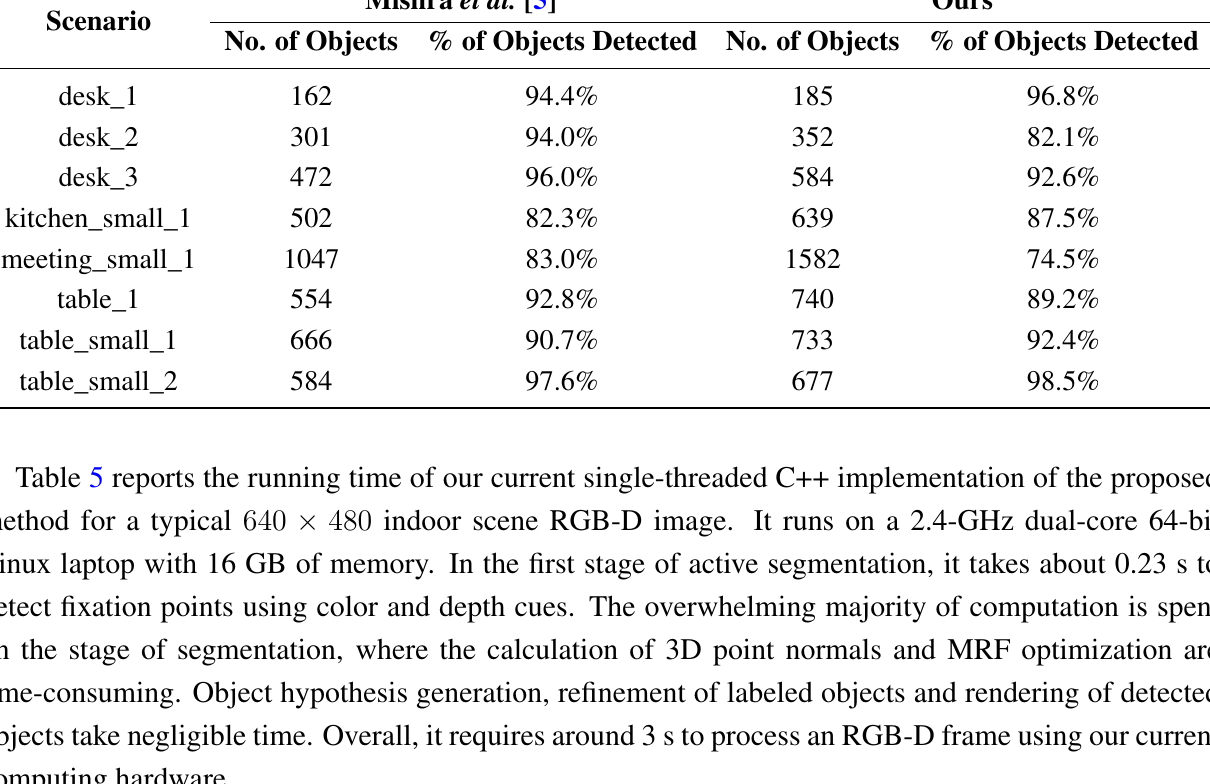
Table 5. Running time of the proposed